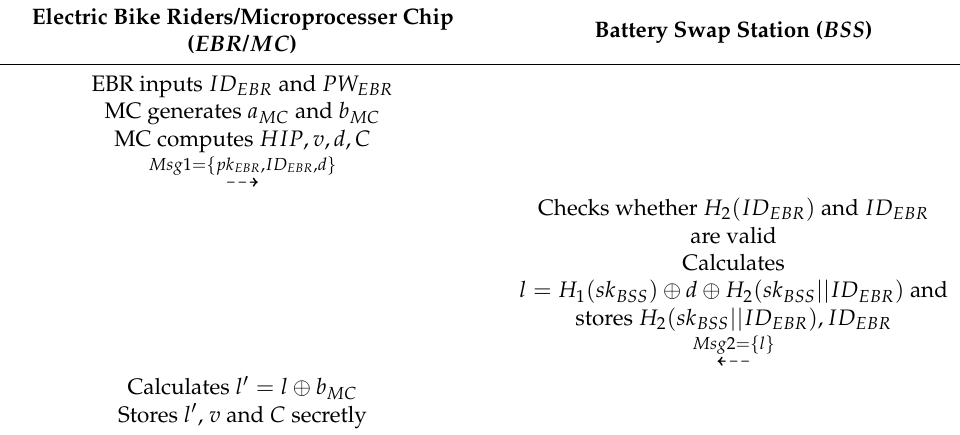
Table 3. User registration